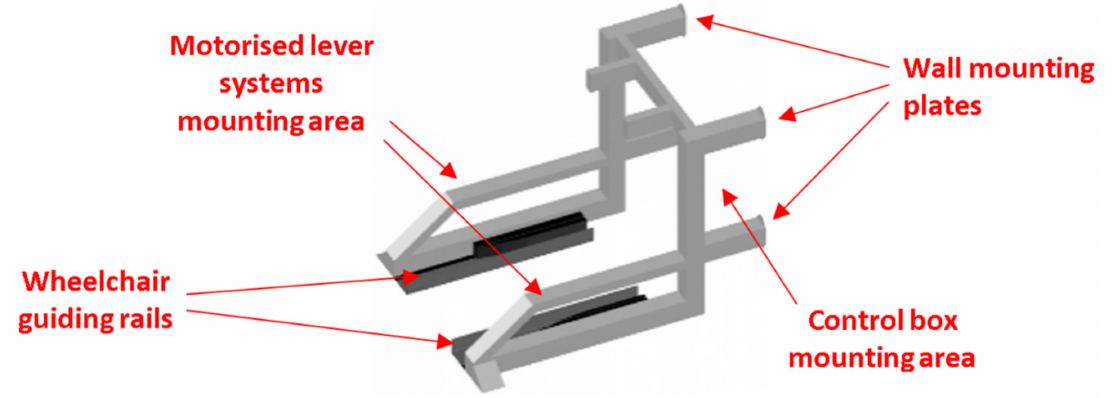
Figure 5. 3D drawing of the steel frame during the design